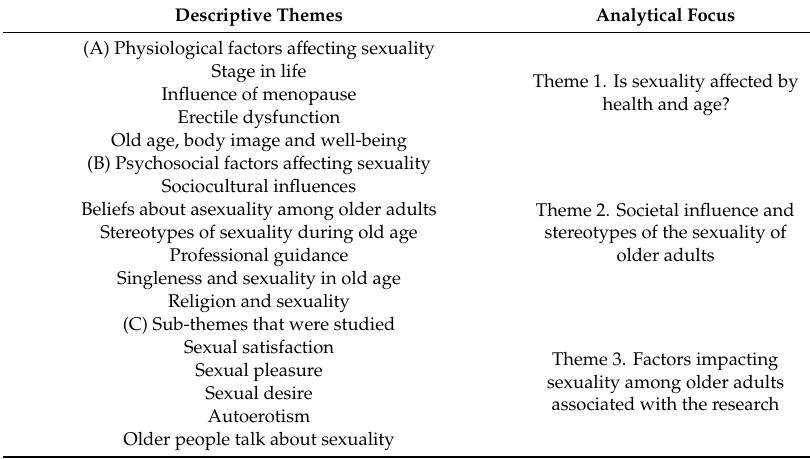
Table 5. Main findings of the thematic